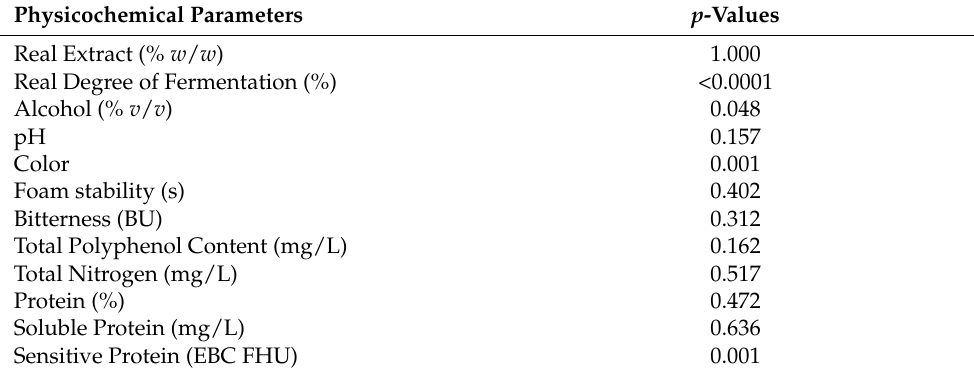
p -value < 0.05 = statistically significant